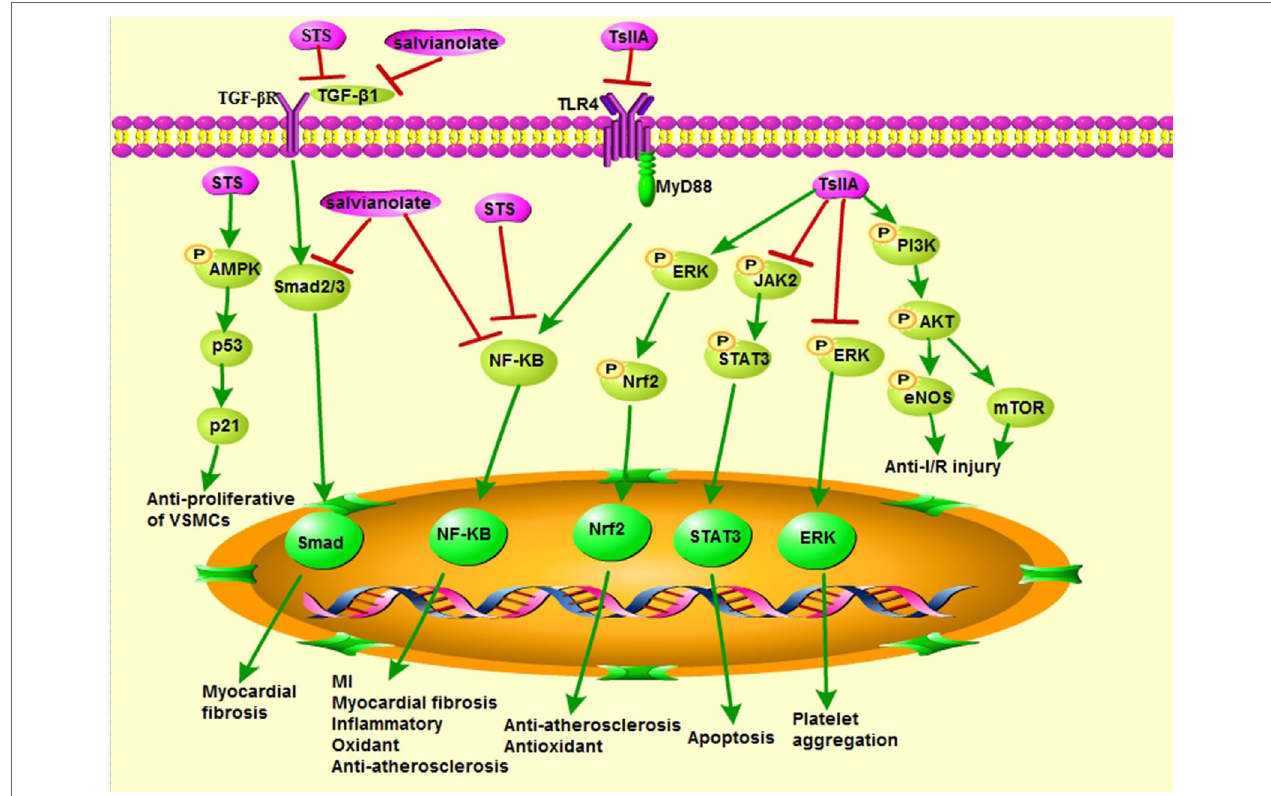
FIGURE 4 | Cardiovascular pharmacological effects of TsIIA, STS, and salvianolate (modified based on Li et al.,